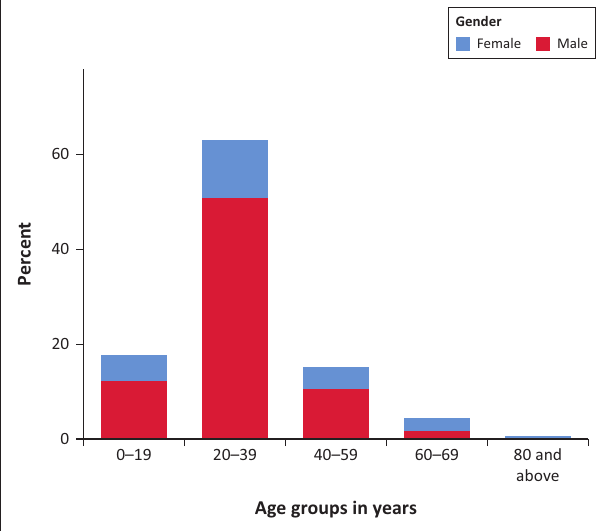
FIG URE 1: Age distribution of head injury patients ( n = 200, missing data =